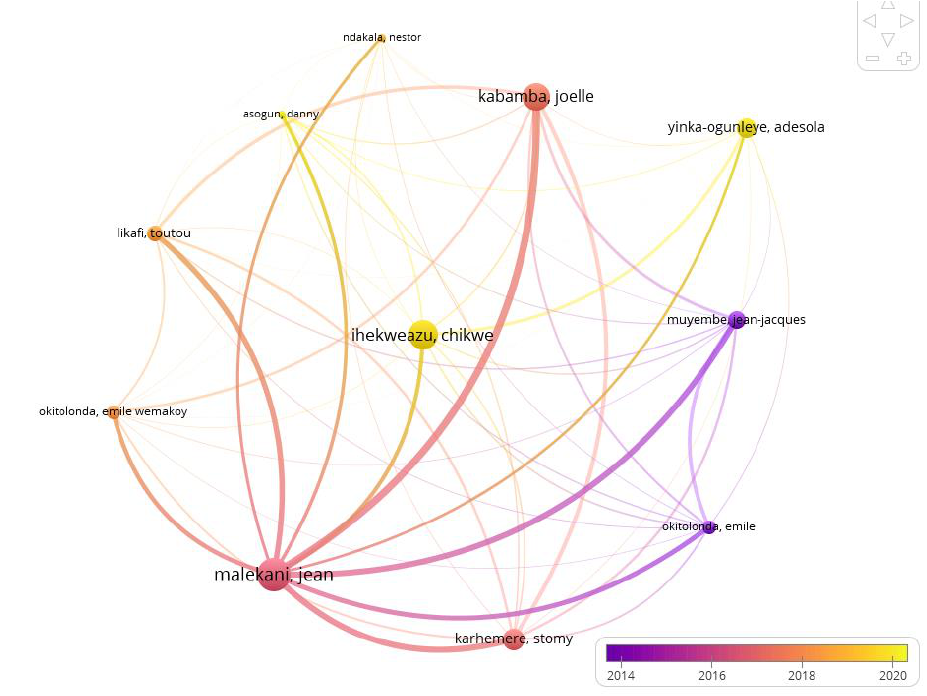
Figure 4 . Co-occurrence networks of the top ten most prolific authors of monkey pox related research in Africa. Yellow color = Authors with recent publications (2019-2022)